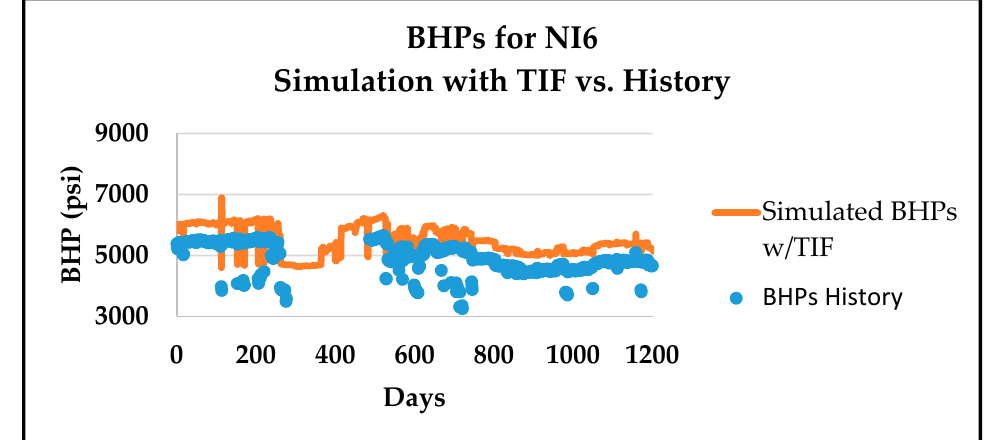
Figure 30. Well NI6 calculated via with TIF simulated reservoir vs. historical data.